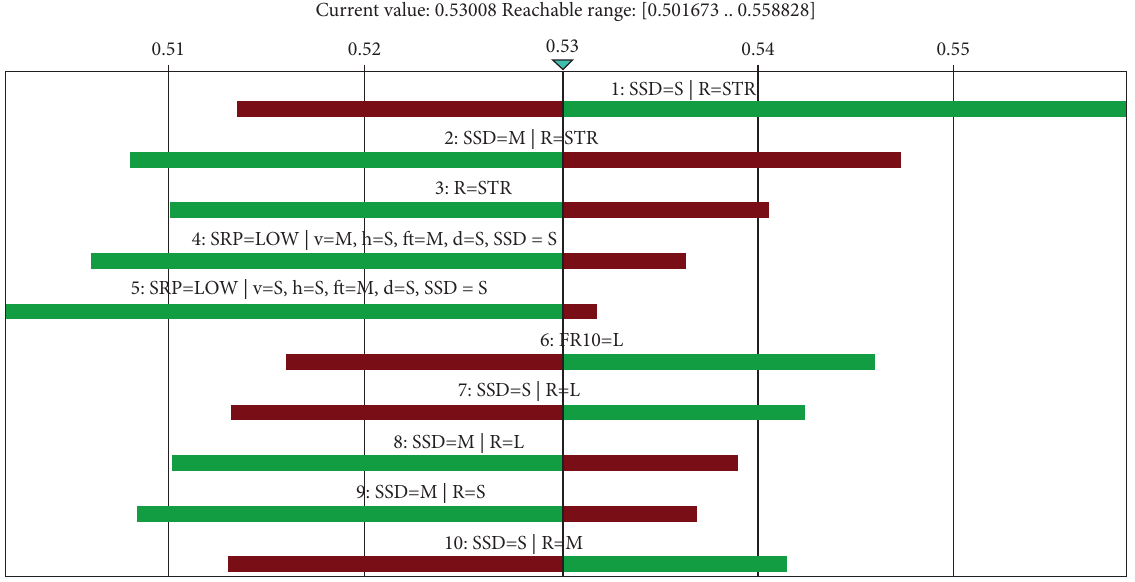
Figure 8: Sensitivity analysis of SRP (SRP �